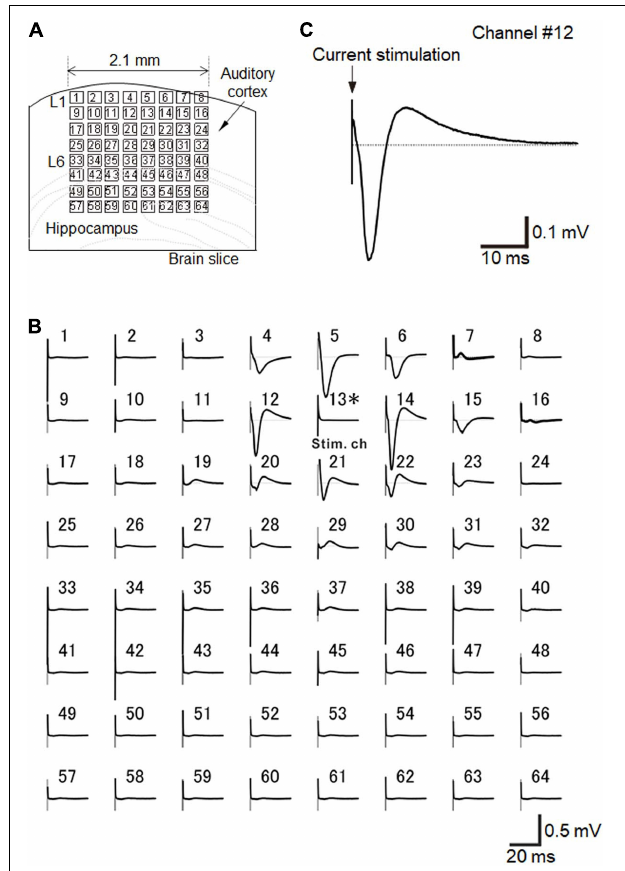
FIGURE 6 | Brain slice arrangement and current-evoked responses. (A) Schematic diagram of a cortical coronal slice on an MEA substrate. Small squares represent the 64 electrodes. The size of each electrode was 50 × 50 µ m 2 , and each inter-electrode interval was 300 µ m. (B) In a slice of the mouse neocortex that included the auditory cortex, evoked LFPs were extracellularly recorded on the MEA substrate with 64-channel (Ch) electrodes. Averaged LFP responses evoked via current stimulation at a single electrode (Ch 13), which was in layer 2/3. Each average waveform was obtained over 10 trials. The stimulation current intensity was 25 µ A. (C) Typical LFP response waveform recorded at Ch 12 in response to a short current stimulation. The LFP response trace is the same as in (B) . Similarly, the average waveform was obtained over 10